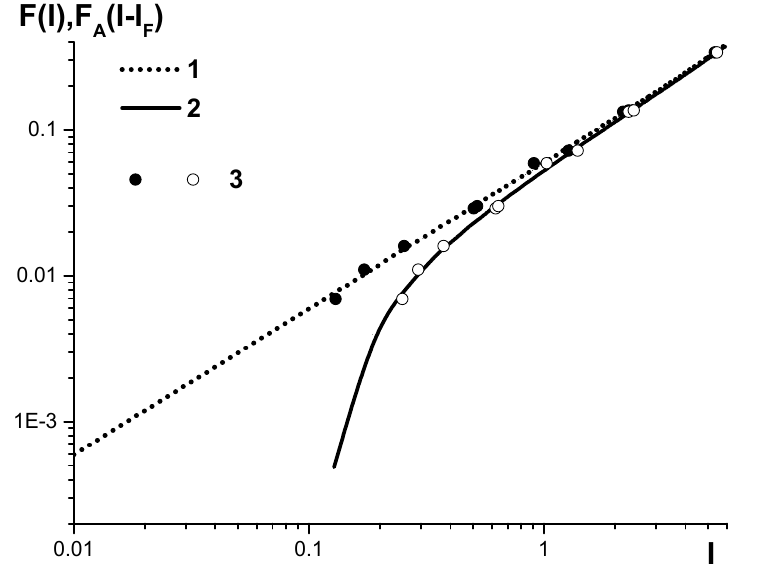
Figure 8. The same as shown in Figure 7, only to determine Ti in low- and medium-alloyed